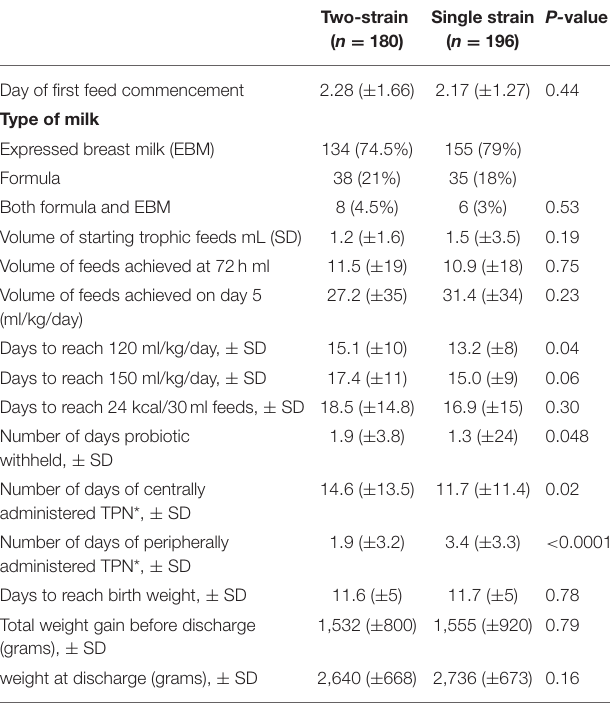
TABLE 2 | Feeding outcomes of preterm infants in single versus two-strain probiotic